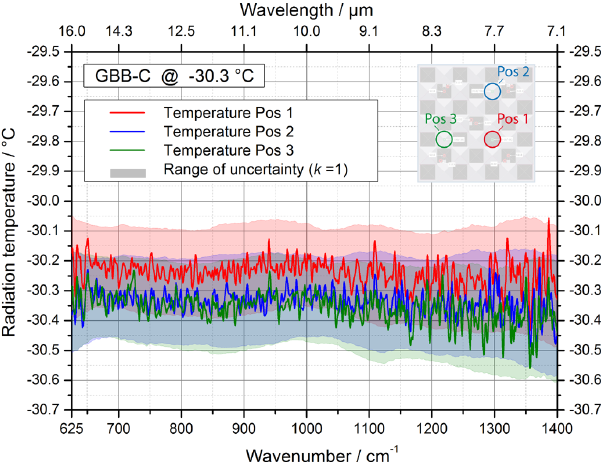
Fig. 17. The spatial distribution of the radiation temperature of the GLORIA blackbody GBB-H at a nominal temperature of 0 ◦ C and 100hPa. The field-of-view is 82mm × 82mm. The measured data is shown on the left panel, the spline interpolated data on the right. The homogeneity is 47mK (standard deviation).